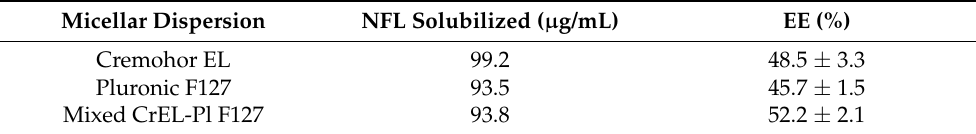
Table 2. Amount of Norfloxacin (NFLX) solubilized in polymeric micelles and encapsulation effi- ciency at 25 ◦